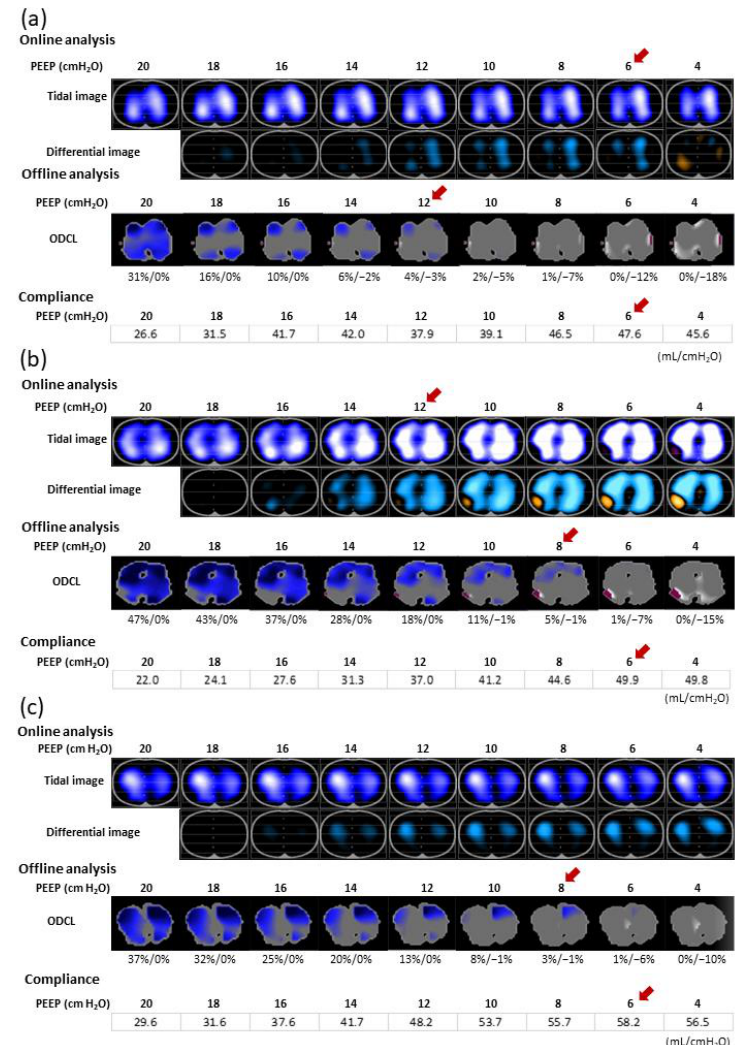
Figure 2. Ventilation distribution pattern 1 in which PEEP ODCL does not correspond with PEEP ONLINE . ( a ) In the tidal images of the online analysis, bright-colored regions represent well-ventilated areas, whereas dark-colored areas represent less-ventilated areas. In the differential images of the online analysis, regional differences displayed in blue, and orange indicate increases and decreases, respectively, compared with reference data. Ventilation loss (orange) is evident in the dependent region at PEEP 4 cmH 2 O in the differential image. PEEP ONLINE is 6 cmH 2 O. In ODCL images of the offline EIT analysis, blue-colored regions indicate overdistention, and white-colored regions indicate collapse. PEEP ODCL is 14 cmH 2 O, which differs substantially from PEEP ONLINE . PEEP COMPLIANCE is 6 cmH 2 O. ( b ) In differential images of the online analysis, focal ventilation loss on the right side in the dependent lung region and ventilation increase occur simultaneously in the same dependent lung region when lowering PEEP. PEEP ONLINE is 12 cmH 2 O. In the offline analysis, PEEP ODCL is 8 cmH 2 O, which differs substantially from PEEP ONLINE . PEEP COMPLIANCE is 6 cmH 2 O. ( c ) In tidal images of the online analysis, ventilation in the dependent lung region remains low and almost unchanged, regardless of the PEEP level. Ventilation loss cannot be de- tected at any PEEP level in differential images; thus, PEEP ONLINE cannot be determined based on ventilation loss in the dependent region. In the offline analysis, PEEP ODCL is calculated as 8 cmH 2 O. PEEP COMPLIANCE is 6 cmH 2 O. EIT, electrical impedance tomography; ODCL, overdistended and collapsed lung; PEEP, positive end-expiratory pressure; PEEP ODCL , PEEP levels using ODCL by offline analysis; PEEP ONLINE , PEEP determined by online analysis; PEEP COMPLIANCE , PEEP with maximal compliance during the PEEP